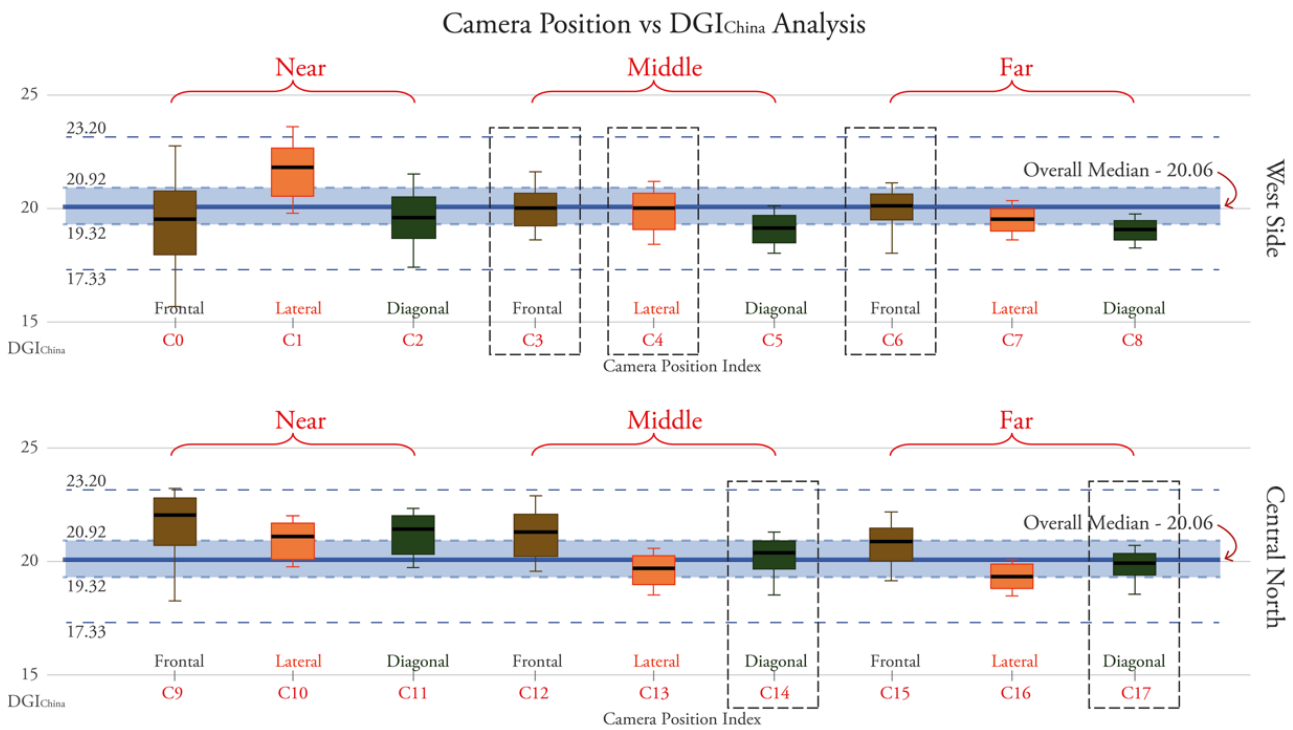
Figure 13. DGI China results by Camera Position Index.